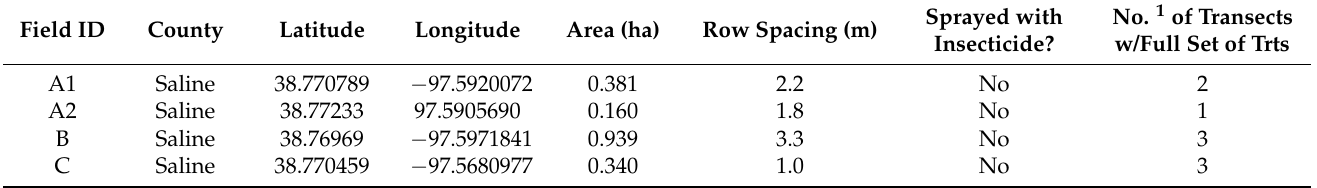
Table 1. Summary of field site characteristics for the trapping study in Kansas during 2019 and